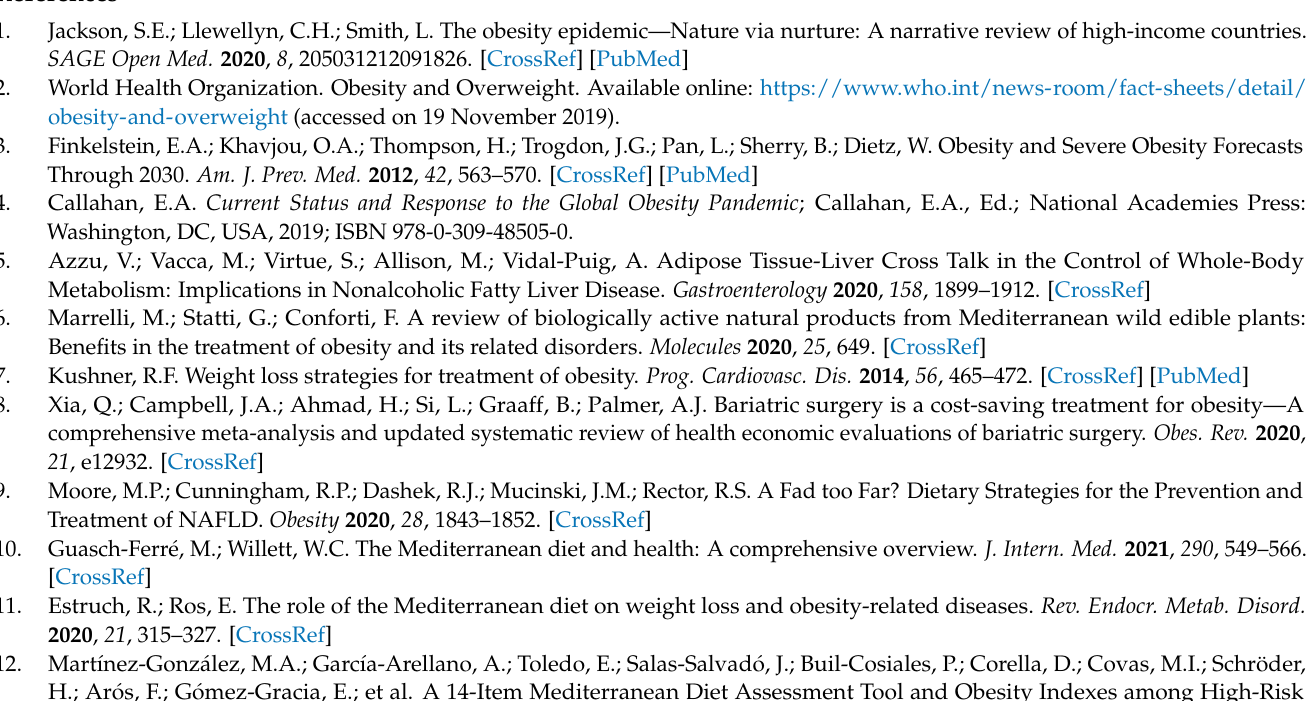
Table S3. Characterization of carotenoids and phenolic compound contents in tomato sofrito